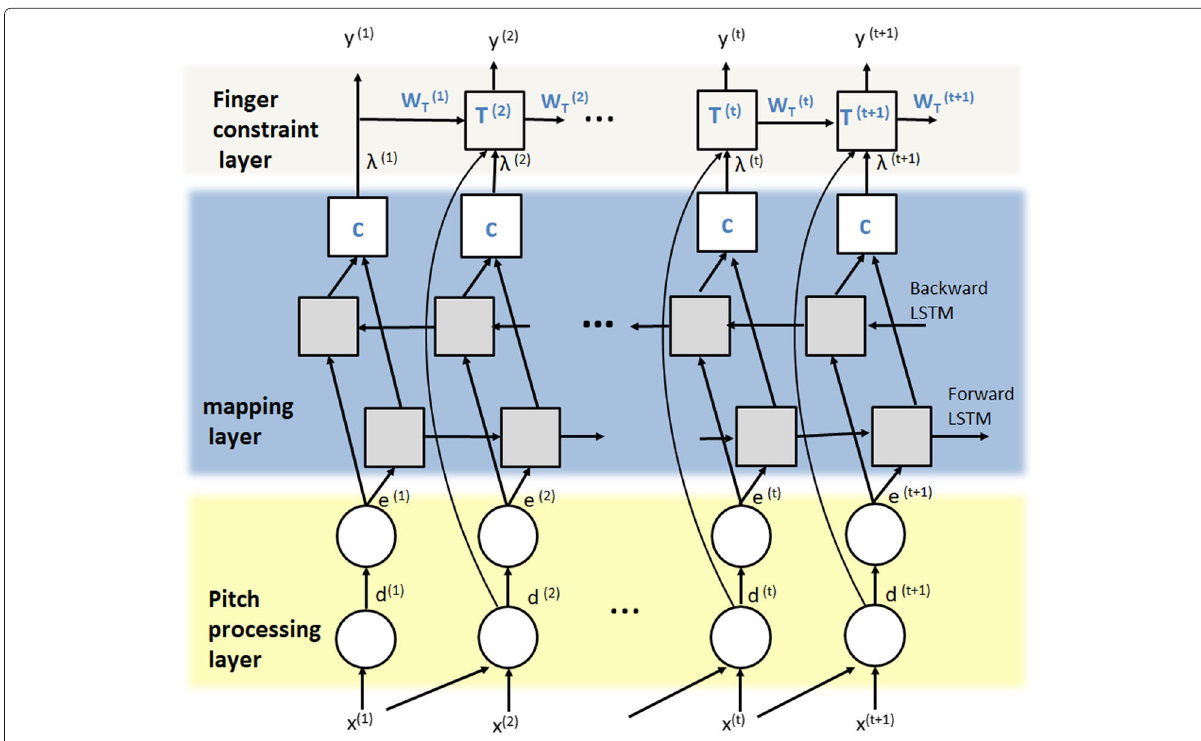
Fig. 1 Pitch-difference fingering annotation